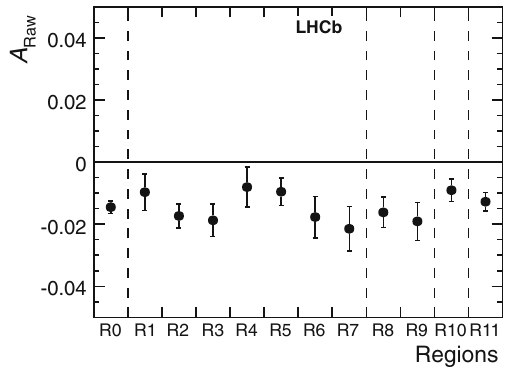
Fig. 9 The measured A Raw in regions in signal Ξ + c → pK − π + can- didate decays for the combined data collected in 2011 and 2012. R0 corresponds to full Dalitz plot and R2 is separated into R8 and R9, R10 is separated into R4 and R5, R11 is separated into R4, R5, R6 and R7, and these regions are correlated and separated by dashed lines